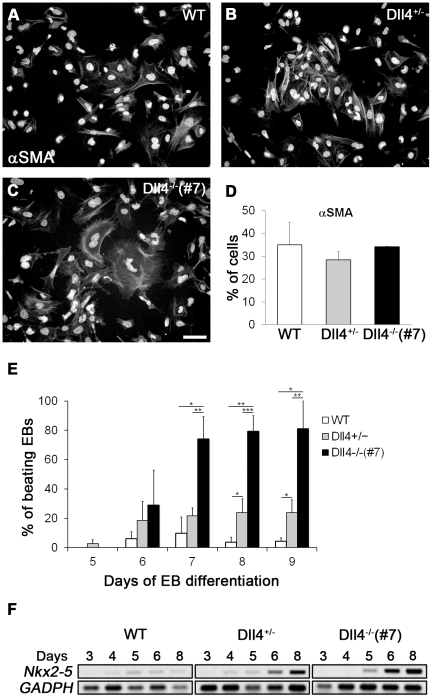
Differential effects of Dll4 on the emergence of SMCs and cardiomyocytes.(A–C) Representative immunofluorescence images for αSMA (cytoplasmic positive fibers), counterstained with DAPI (nuclear staining), of day 3 EB-derived cells cultured for 5 days in monolayer culture. (D) Percentage of αSMA+ cells obtained from day 3 EB-derived cells of WT, Dll4+/− and Dll4−/− cell lines. (E) Percentage of beating EBs in suspension culture from day 5 to day 9 of differentiation. (F) Semi-quantitative RT-PCR analysis of Nkx2-5 in WT, Dll4+/− and Dll4−/− EBs from day 3 to day 8 of differentiation. Scale bar represents 10 µm. *P<.05, **P<.01, ***P<.001.